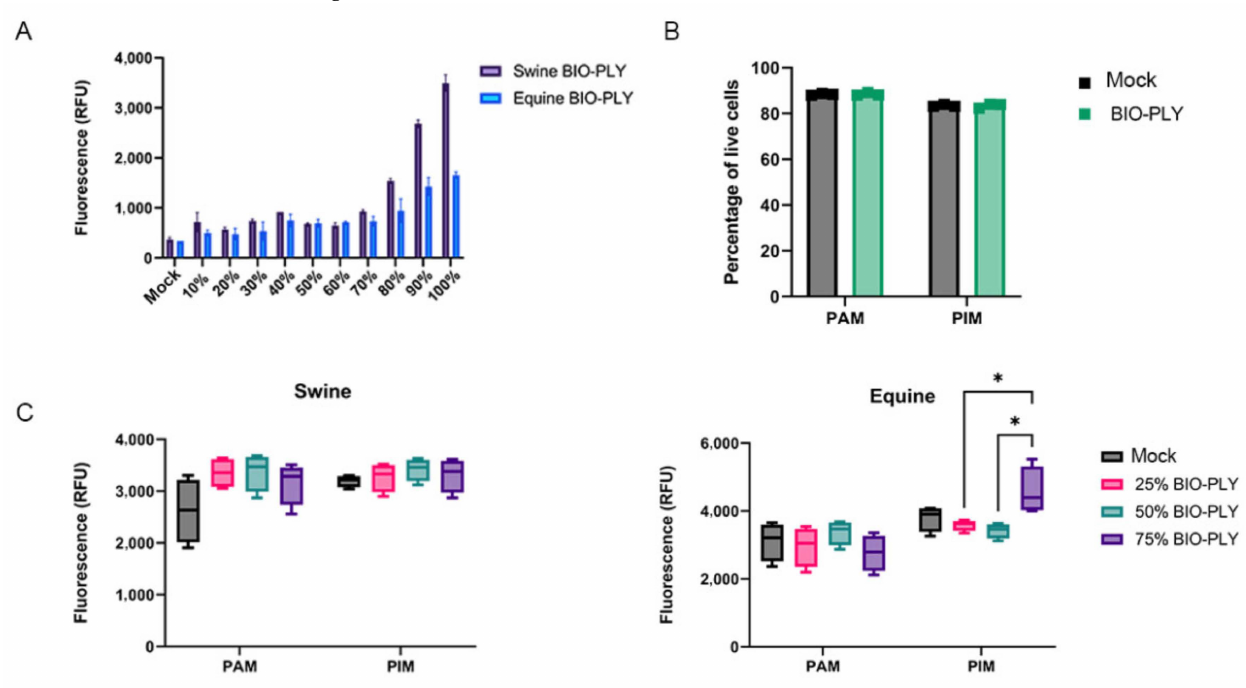
Figure 7. Cell viability and BIO-PLY TM cytotoxicity in cell line and primary macrophages PAM and PIM. ( A ) Effect of different BIO-PLY TM concentrations in NPTr cell line using the Promega CellTox green cytotoxicity assay. ( B ) Effect on the viability of PAM and PIM treated with 50% swine BIO-PLY TM for 24 h measured via flow cytometry and LIVE/DEAD staining. ( C ) The impact of swine (left) and equine (right) BIO-PLY TM treatment for 48 h in PAM and PIM using the same Promega kit. All experiments were performed using technical duplicates in 4 biological replicates. Results are expressed as relative fluorescence units (RFU) and were analyzed via two-way ANOVA and displayed showing means and standard error of mean (SEM). p -values were expressed using asterisks following APA and Prism standards. * p ≤